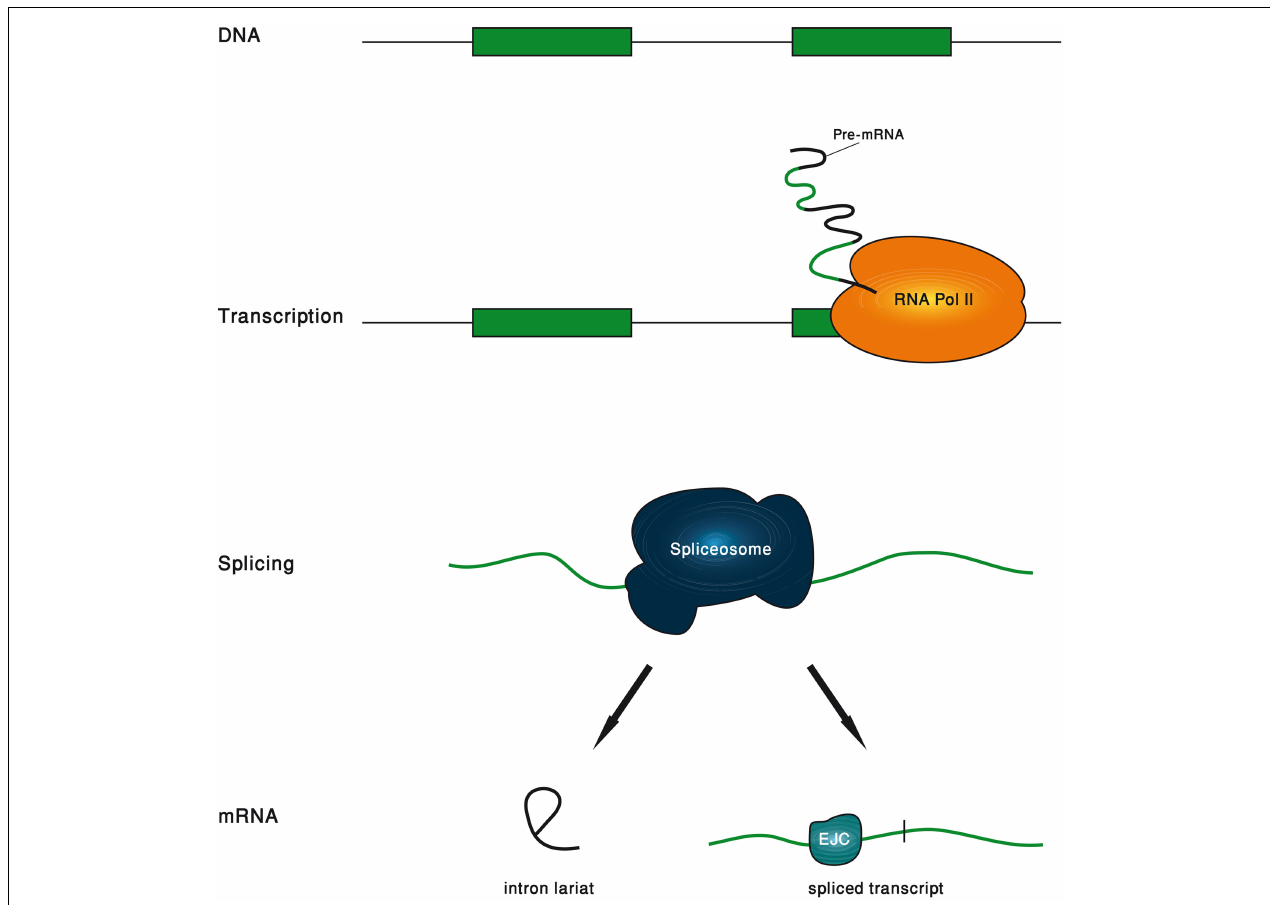
FIGURE 1 | Schematic description of the five phases of an intron life